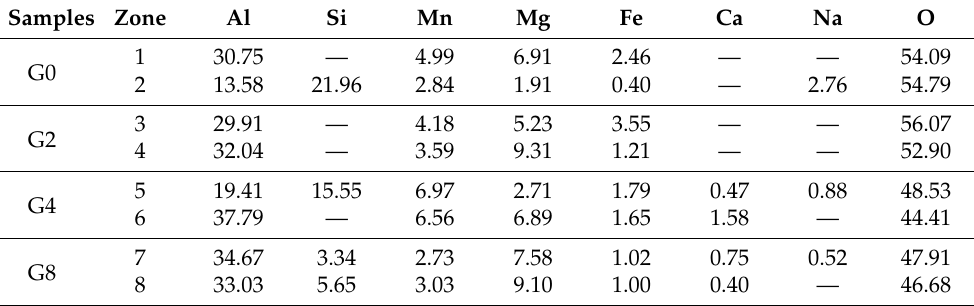
Table 5. EDS analysis of different zones in corroded samples (at.%).